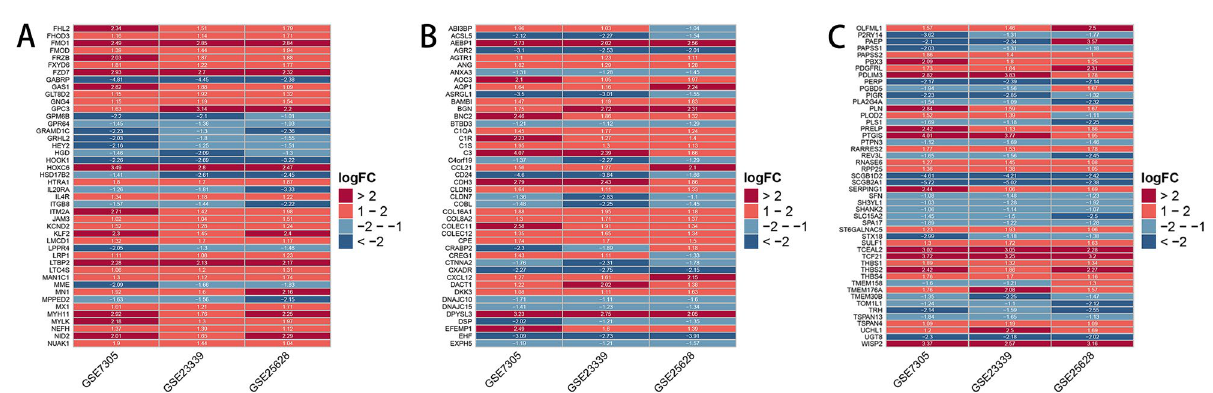
Figure 4. Heat maps of the DEGs in endometriosis microarray datasets. The vertical column is the name of the data set, the horizontal column is the gene name. DEGs are those genes with P value < 0.05 and |log (FC)|> 1. Red indicates up-regulation and blue indicates down-regulation.